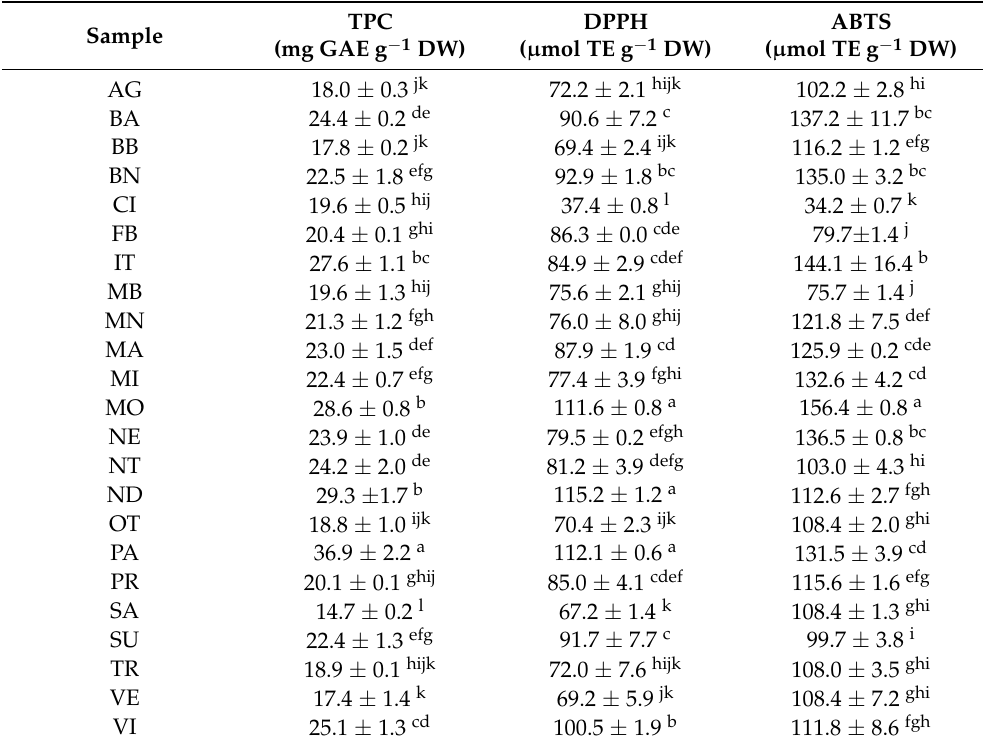
Table 4. The total phenolic content and antioxidant activity of vine shoot extracts from 23 different Italian varieties. Means and standard deviation ( n = 2) are represented in the same column and data followed by different letters indicate statistically significant differences according to the Fisher test ( p < 0.05). For sample codes, see Table